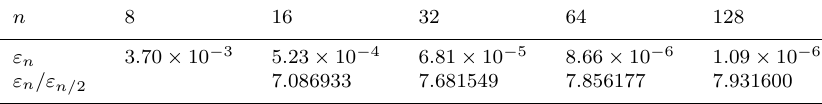
Table 5. Numerical results for f ( x ) = | x 3 | , x ∈ [ − 1 , 1] , uniform mesh, n odd. n 5 ε n